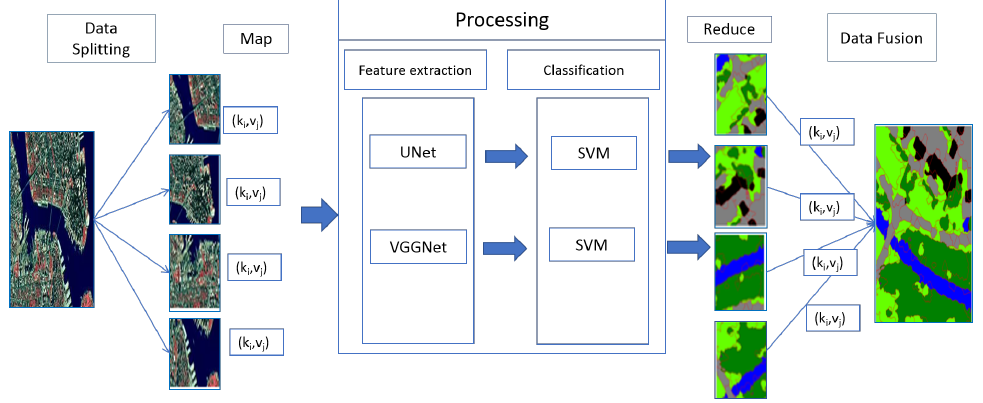
Figure 4. The processing